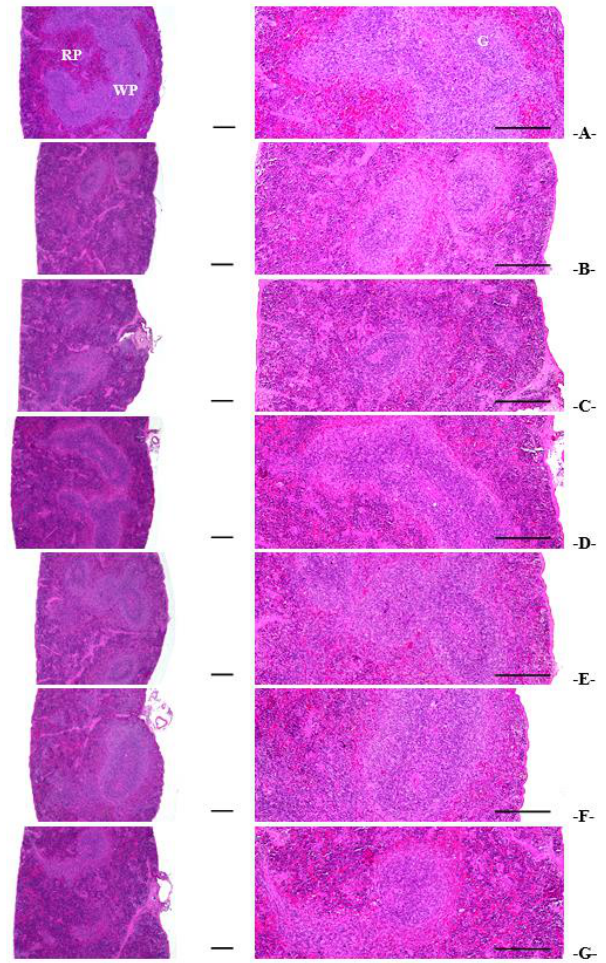
Figure 13. Representative histological profiles of the spleens taken from intact or NCI-H520 tumor cell xenograft mice. ( A ) = Intact control; ( B ) = tumor-bearing control; ( C ) = gefitinib 120 mg/kg; ( D ) SKOG 400 mg/kg; ( E ) = gefitinib 120 mg/kg and SKOG 400 mg/kg; ( F ) = gefitinib 120 mg/kg and SKOG 200 mg/kg; ( G ) = gefitinib 120 mg/kg and SKOG 100 mg/kg. AR = Adenophorae Radix; KOG = Kyeongokgo ; SKOG = sasam-Kyeongokgo . WP = white pulp; RP = red pulps; G = secondary follicle. All Hematoxylin-Eosin-stained . Scale bars = 200 μm. 3.11.3. Histopathological Changes in the Submandibular Lymph Nodes In the tumor transplantation control group, atrophy was confirmed due to a signifi- cant decrease in the number of lymphocytes in the lymph node cortex, and a significant decrease ( p < 0.01) in the total submandibular lymph nodes and cortical thickness and the number of intracortical follicles were confirmed in comparison with the intact control group. However, in the group that received sasam-Kyeongokgo alone or in combination,